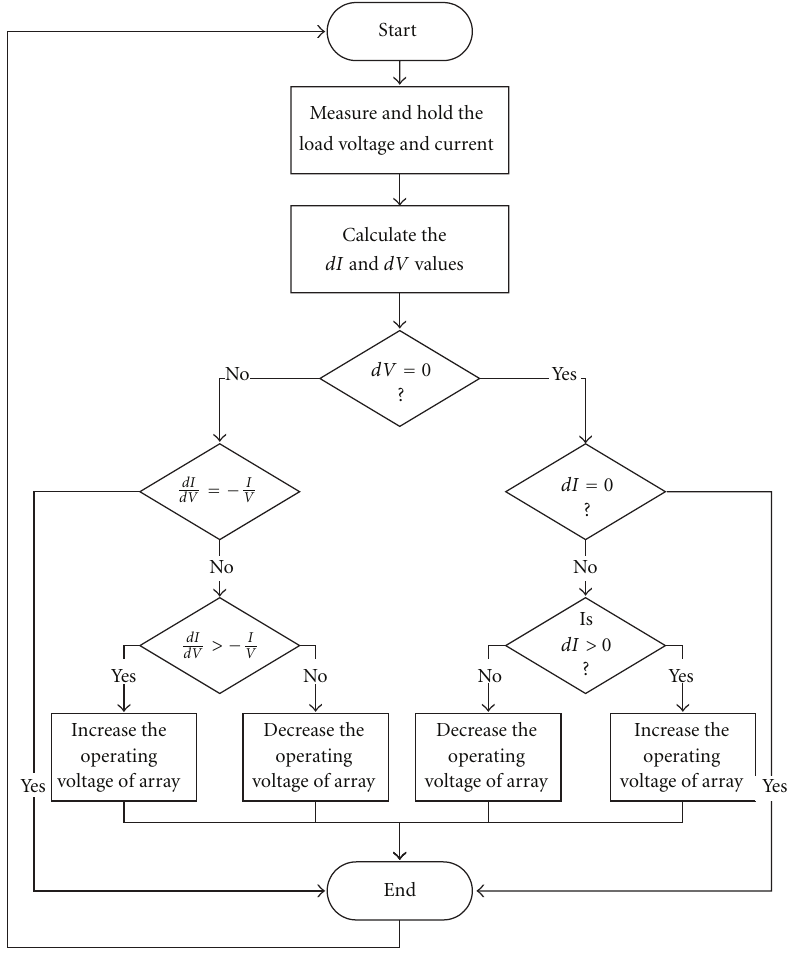
Figure 9: Flowchart of IC algorithms for MPPT